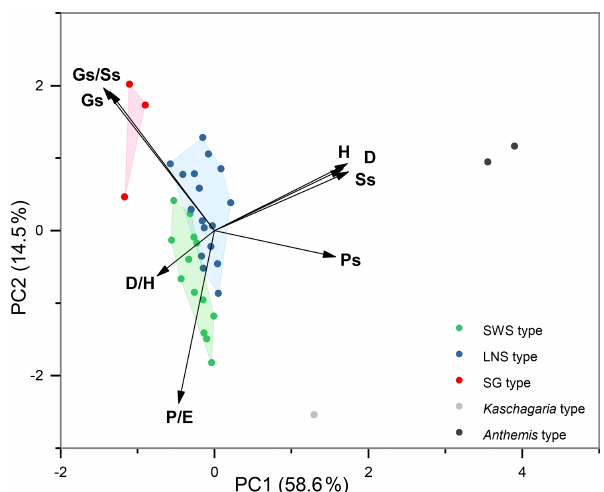
Figure 18. Principal component analysis of 36 taxa of Artemisia and its